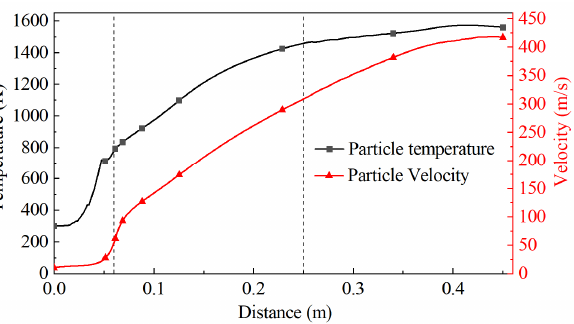
Figure 5. Change curve of the particle temperature and velocity along the central axis.